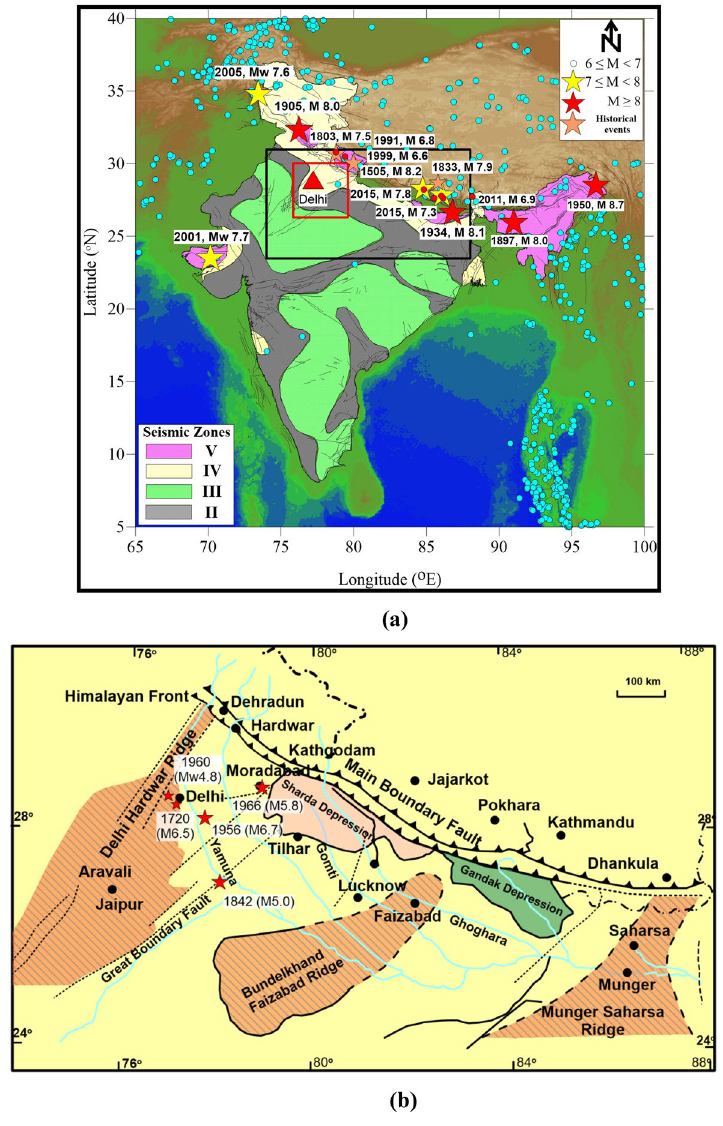
Figure 1. ( a ) Seismicity of Himalaya (magnitude ≥ 4.5 from 01.01.1900 to 10.06.2020) taken from USGS and overlapped on SRTM data of 90 m resolution (http:// srtm. csi. cgiar. org). The Ganga basin area is shown with a black rectangle. The red rectangle represents Delhi and surroundings. ( b ) the structure of the basement of the Ganga Basin based on Fuloria1 and Sastri et al.2 overlapped with the epicenter of earthquakes of Delhi region. The figure is prepared using Generic Mapping Tools version 4.4.0 3